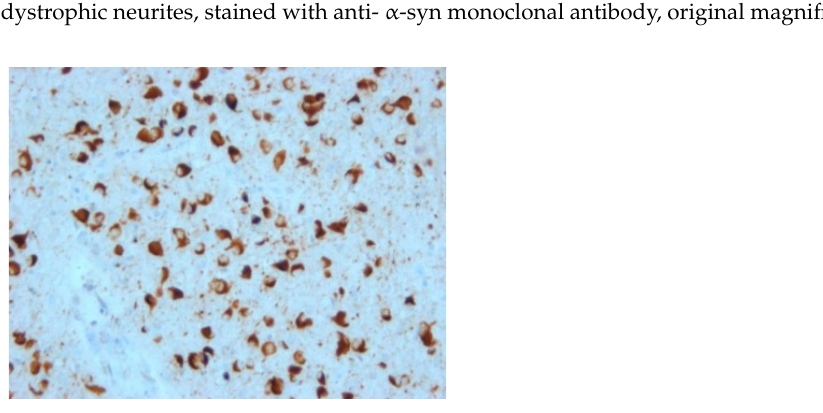
Figure 3. Neuropathological finding showing changes in multiple system atrophy. Typical alpha- synucleinopathy with oligodendroglial cytoplasmic inclusions in striatum, stained with anti- α -syn monoclonal antibody, original magnification 200×.